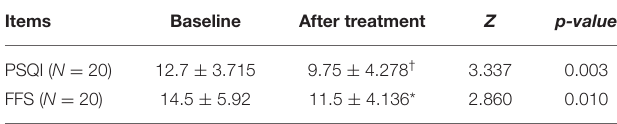
TABLE 2 | Improvement of PSQI and FFS after 4-weeks taVNS treatment ( x ± s).